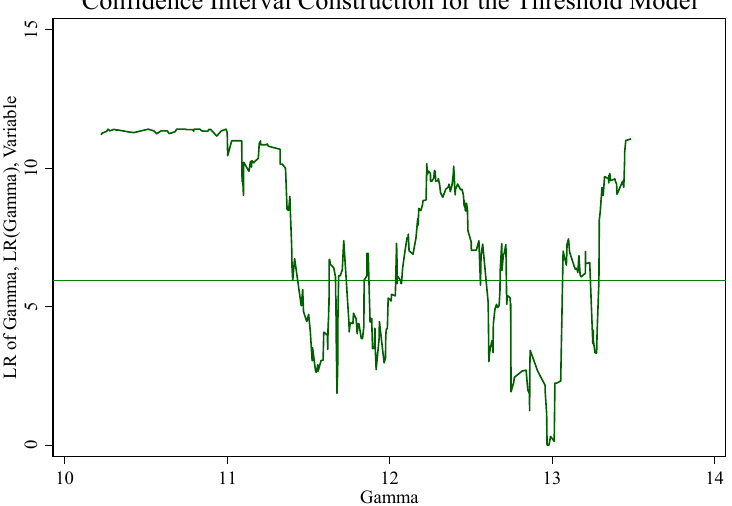
Figure 6. Results of the LR statistical test for dynamic changes. Note: Created by the author using Stata 17.0.